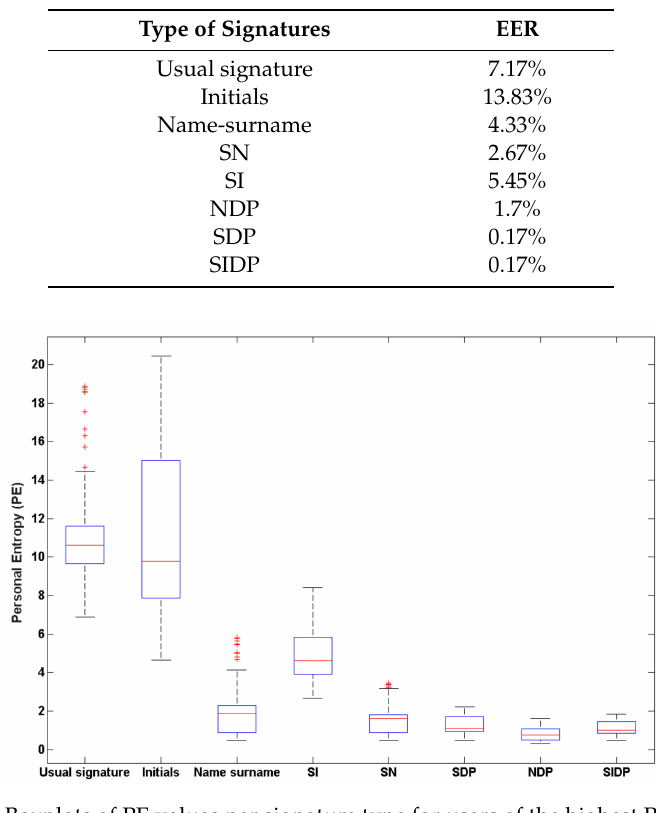
Table 3. System performance on users of the highest PE category in terms of EER.